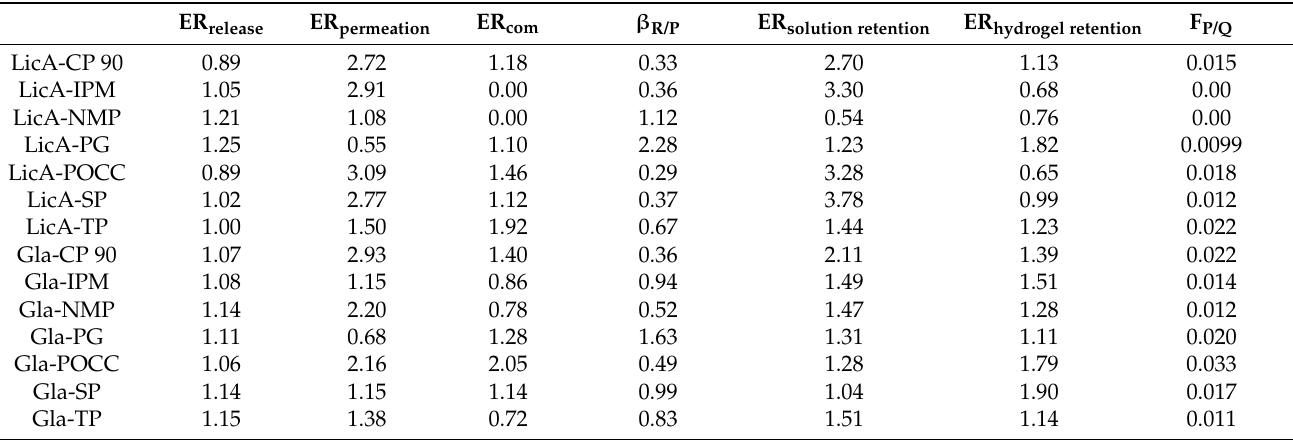
Table 3. The enhancement efficacy parameters of enhancers in the drug release and skin penetration